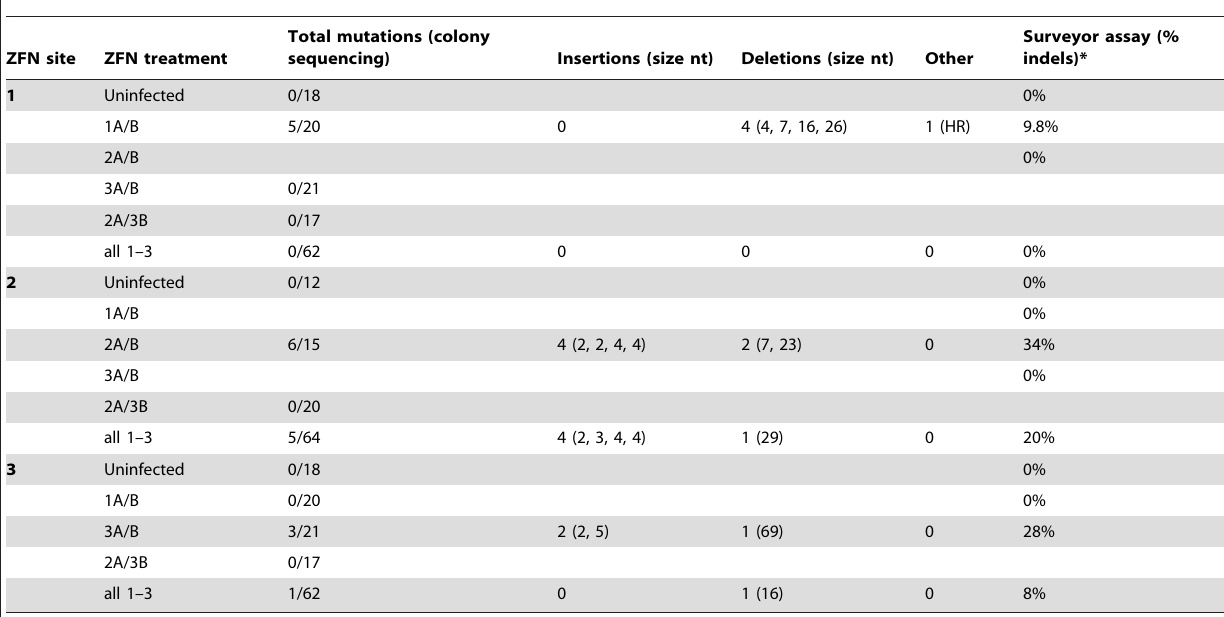
Table 1. Summary of HBV-ZFN-induced mutagenesis in HepAD38 cells.